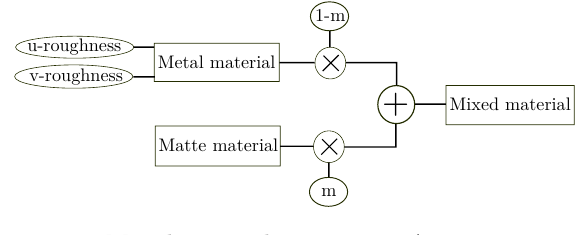
Figure 7: Mixed material generation. A Luxcore metal material is defined by the roughness in the perpendicular directions u and v . The metal material is mixed with a matte material with a mix factor m